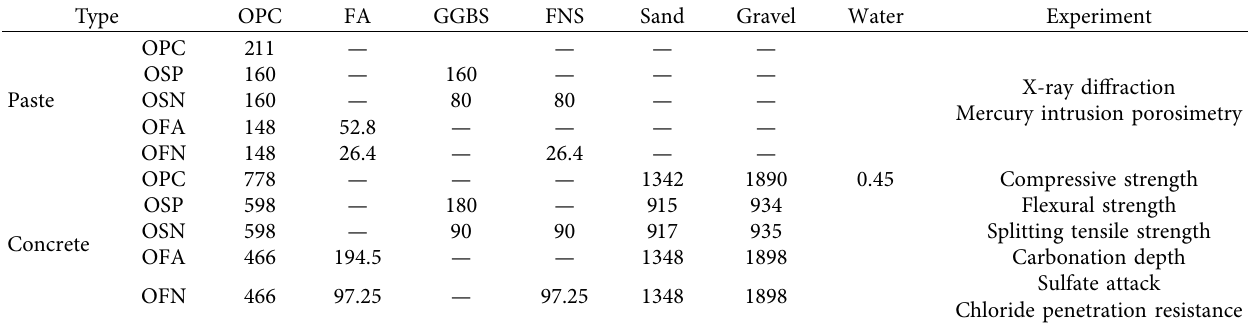
Table 2: Mix proportion and experiments